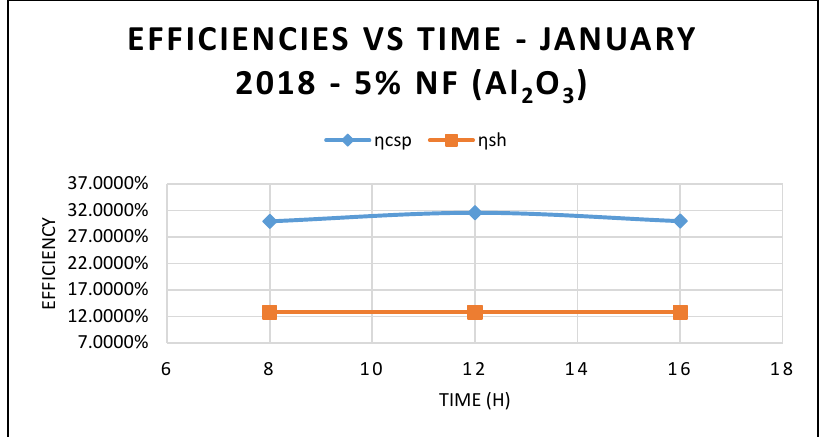
Figure 9. Efficiencies of the CSP collector and hybrid system at a concentration of 5% Al 2 O 3.